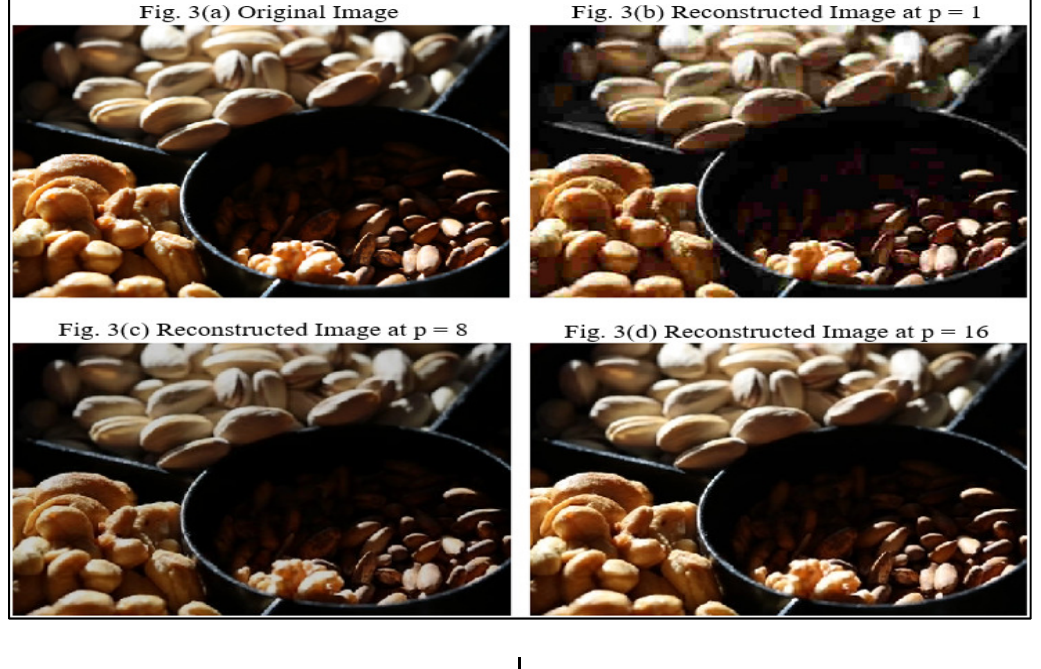
TABLE 3. RESULTS OBTAINED for p